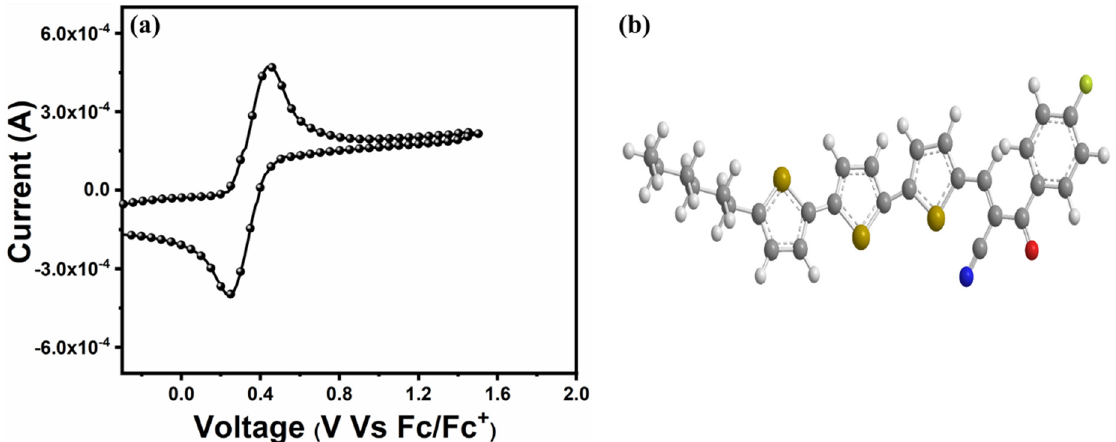
Figure 4 . ( a ) Cyclic voltammogram (CV) and ( b ) 3D structure of H3T-4-FOP SOM. Figure 4. ( a ) Cyclic voltammogram (CV) and ( b ) 3D structure of H3T-4-FOP